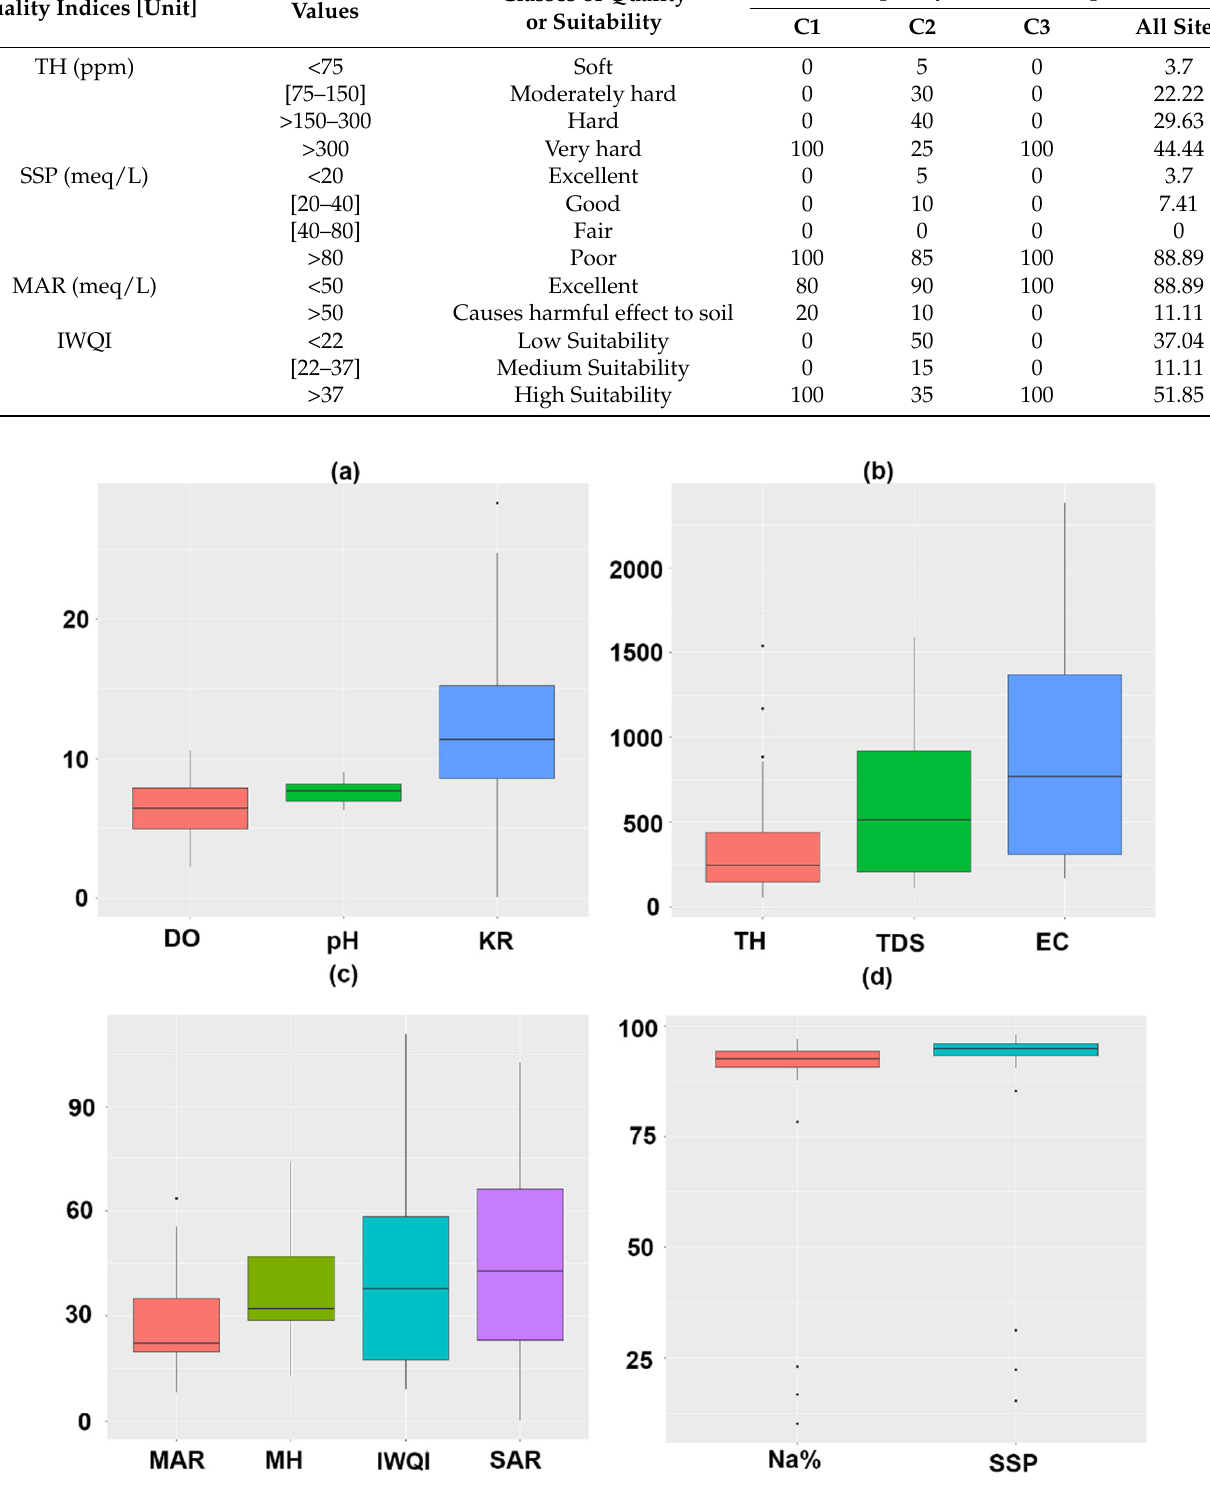
Figure 5. Box plots show irrigation water indices in study area. Unit of RSBC, EC, and TH are mg/L, μ s/cm, and mg/L, respectively. According to the similar concentration the plots have been displayed as ( a ) DO, pH and KR, ( b ) TH, TDS and EC, ( c ) MAR, MH, IWQI, SAR and ( d ) Na% and SSP. Table 3. Classes of quality indices applied for irrigation water in the study area.